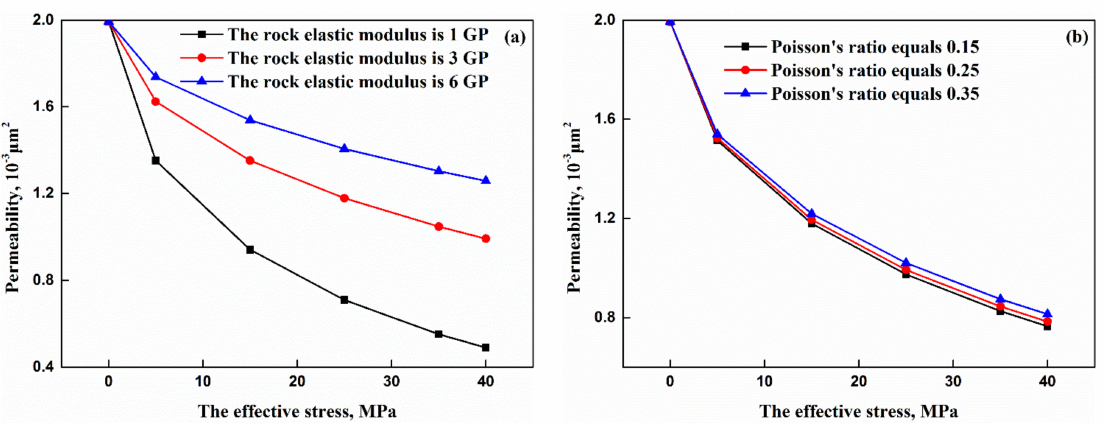
Figure 8. The effect of rock’s mechanical property on permeability: (( a ) rock elastic modulus; ( b ) Poisson’s